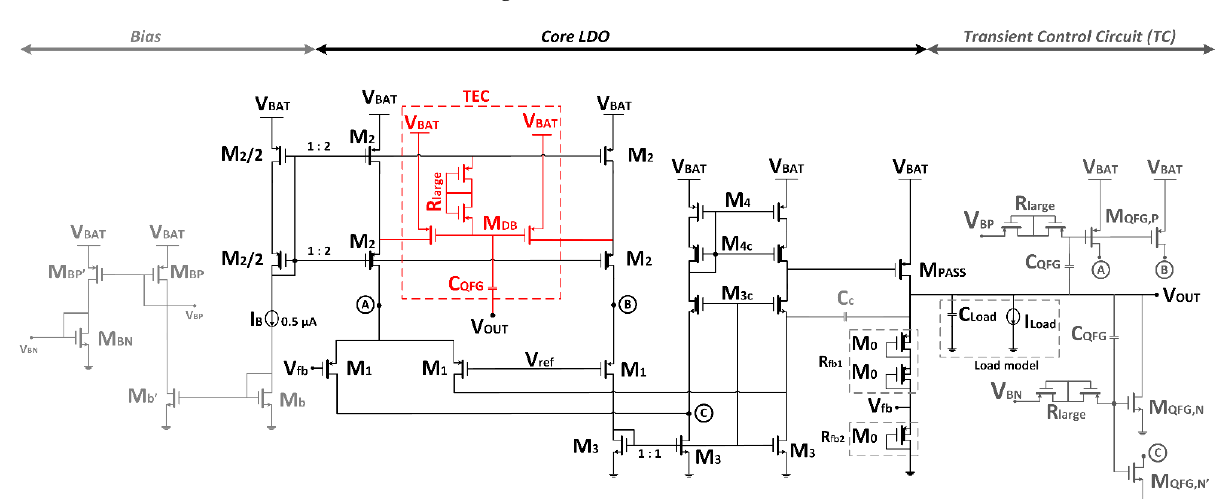
Figure 6. Core structure of the proposed low dropout regulator with transient control circuits.